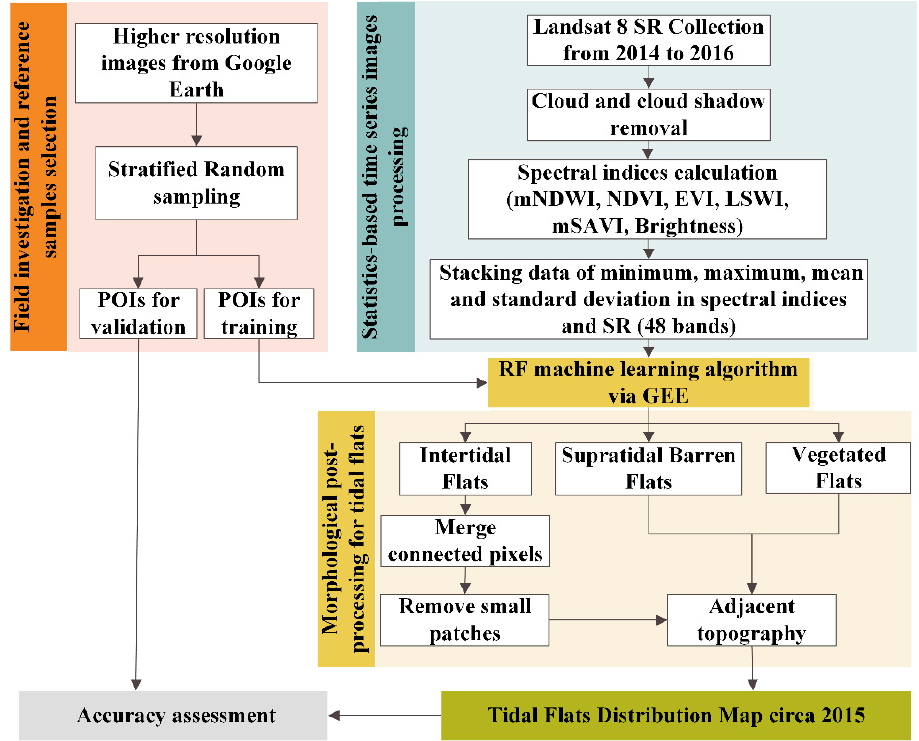
Figure 3. Workflow used in this study for tidal flats mapping.